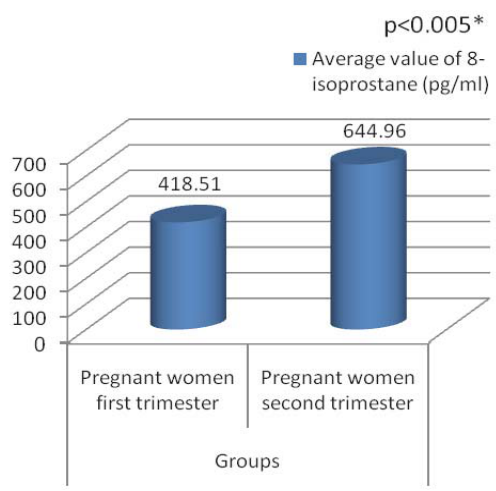
FIGURE 4. - 8 - isoprostane average values for the fi rst tri- mester and the second trimester pregnant women *p – signi fi cancy (if p<0.05 then there is signi fi cant correlation between investigated